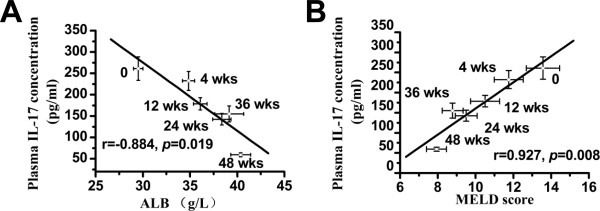
Relationships between IL-17 level and liver function in patients. The relationships between IL-17 level and ALB (A) and MELD score (B) were calculated using the Spearman rank correlation test. The solid line represents the linear growth trend, r means correlation coefficient. ALB, albumin; MELD score, Model for End-Stage Liver Disease score.